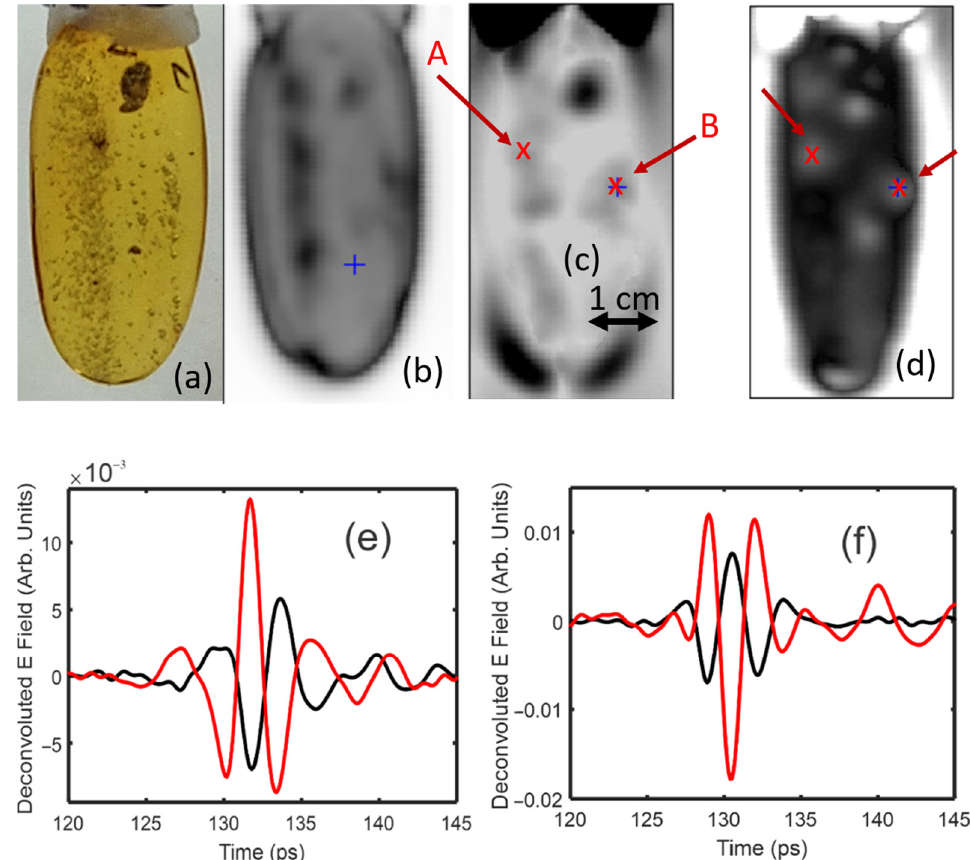
Figure 8. ( a ) Visible image of amber sample. ( b ) Transmitted THz power integrated from 0.5–2 THz. The image is on a logarithmic scale. ( c ) Cross-polarization deconvoluted pulse amplitude for 0 deg configuration. ( d ) Cross-polarization deconvoluted pulse amplitude for 45 deg configuration. ( e ) Deconvoluted pulses for point A. ( f ) Deconvoluted pulses for point B. The E o and E 45 deconvolved waveforms are denoted by the black and red curves, respectively. Note the changes in polarity of the deconvolved pulse amplitudes, indicating a significant change in the localized stress direction.